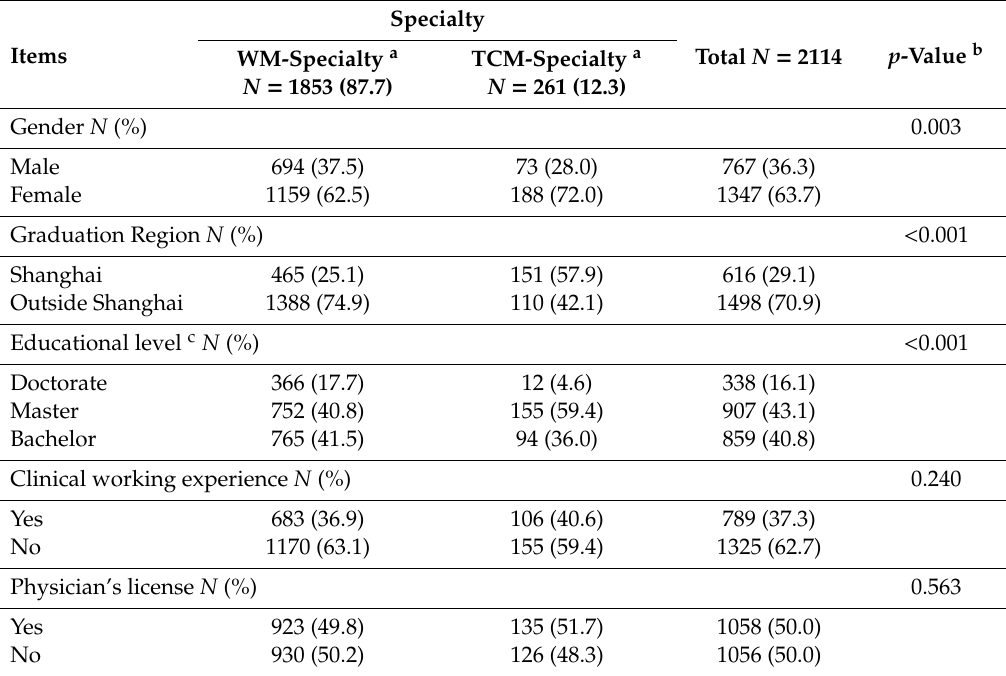
Table 2. Characteristics of the trainees ( N = 2114).